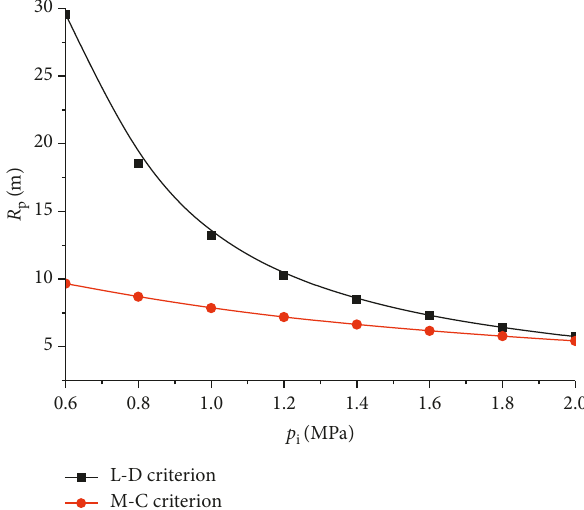
F IGURE 4: Relation curves between support resistance and plastic zone